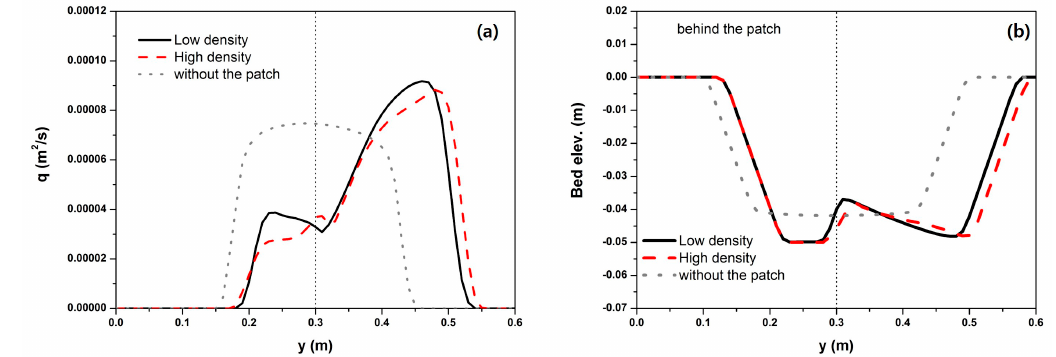
Figure 12. Computational results of ( a ) lateral unit discharge and ( b ) bed profile with different patch densities at y = 4.3 m for case 2.